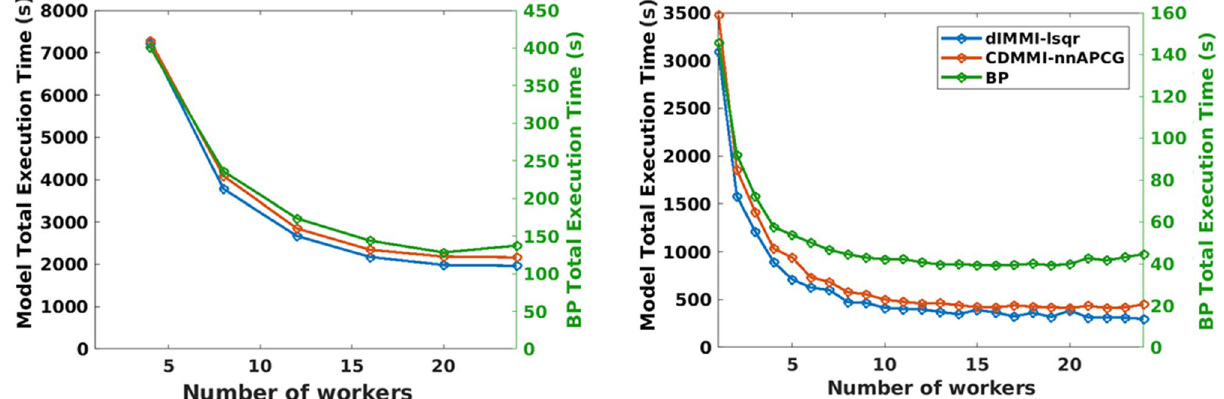
Figure 14. Reconstruction using different algorithms for varying numbers of parallel workers. Both Dataset A (left) and Dataset C (right) benefit from parallelization, though both show diminishing returns. When reconstruction time is normalized to the time required for a single worker (left) or 4 workers (right) to execute, it becomes clear that both model-based approaches benefit greatly from parallelization, while backprojection (BP) more rapidly saturates due to the greater proportion of its reconstruction which is non-parallelizable. For large numbers of workers, it becomes evident that system overhead becomes restrictive, as there is a decrease in relative speedup. Note separate axes for dIMMI and CDMMI (left) versus BP (right). Figure created using a combination of MATLAB and Microsoft